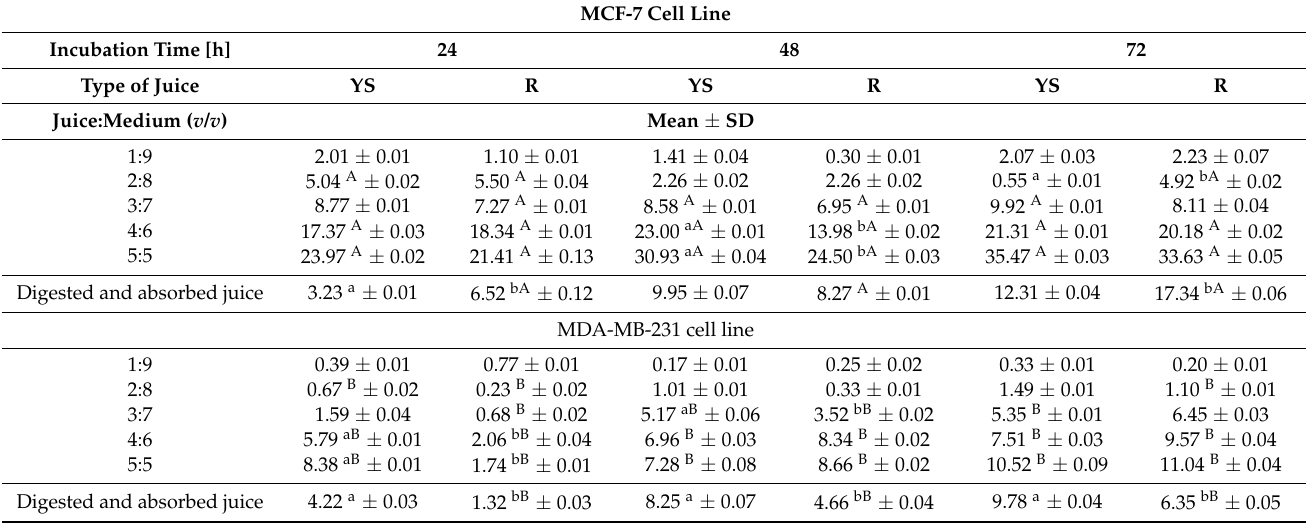
Table 3. Comparison of the cytotoxicity of the analyzed juices against MCF-7 and MDA-MB-231 breast cancer cell lines